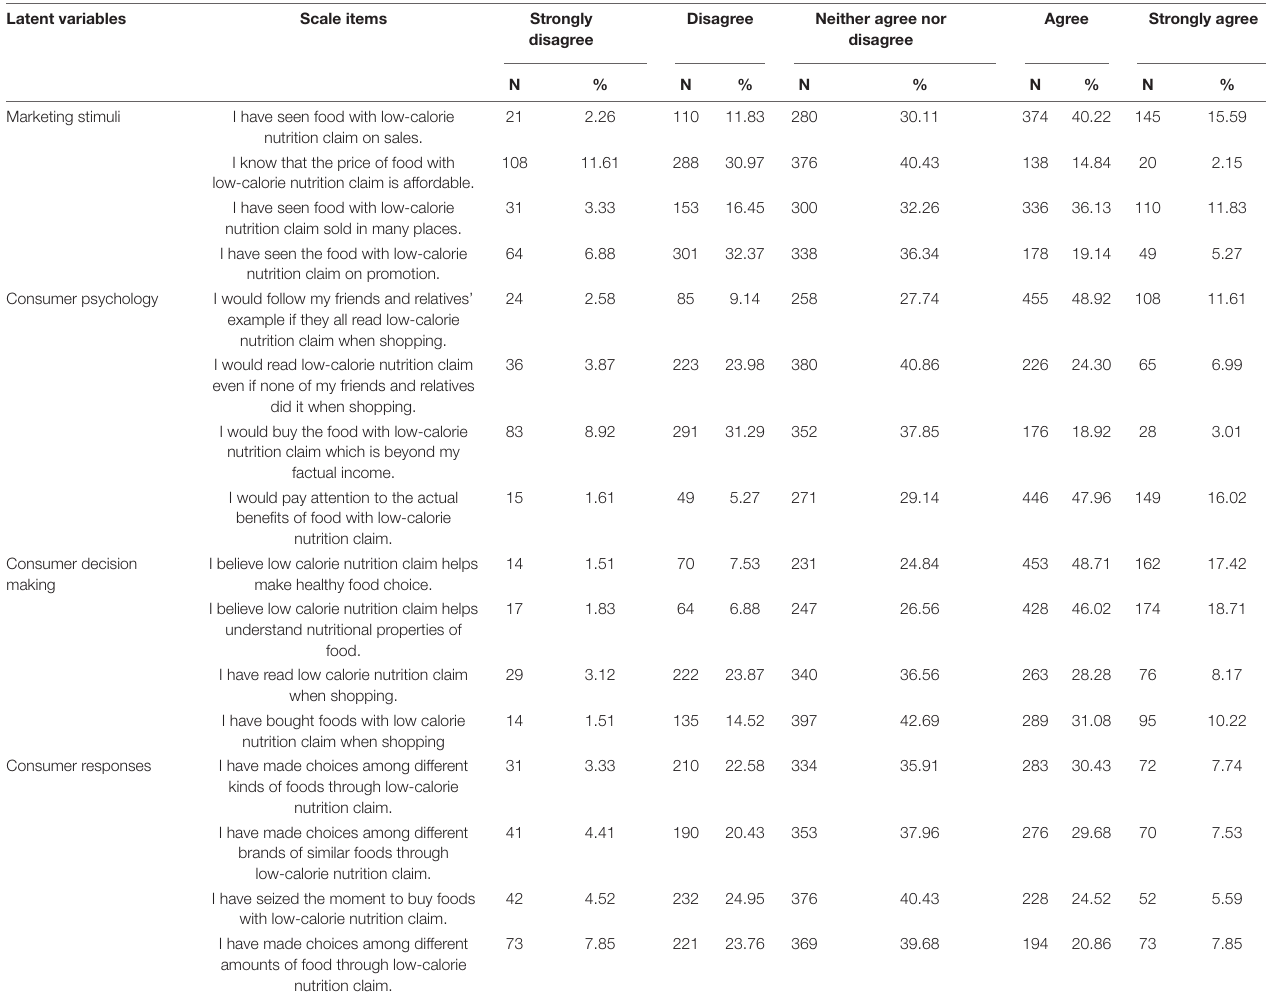
TABLE 2 | Description of latent variables and summary statistics. Latent variables